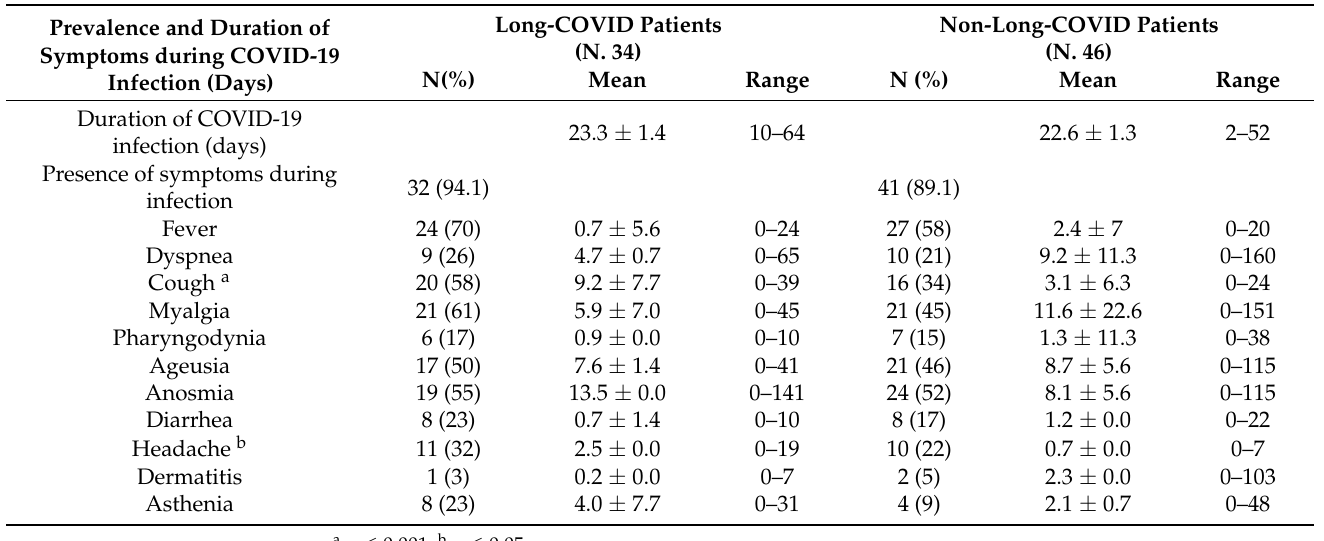
Table 3. Clinical characteristics of COVID-19 in patients subdivided according to the presence (long-COVID patients) or not (non-long-COVID patients) of at least one symptom four months after negativization.